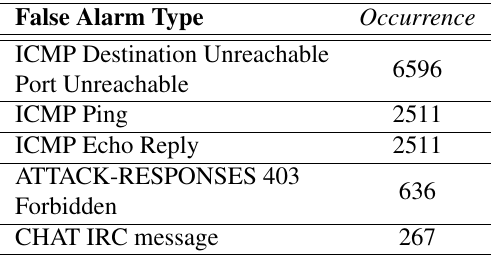
Table 2. The Top 5 frequent types of false alarms in Week1 and